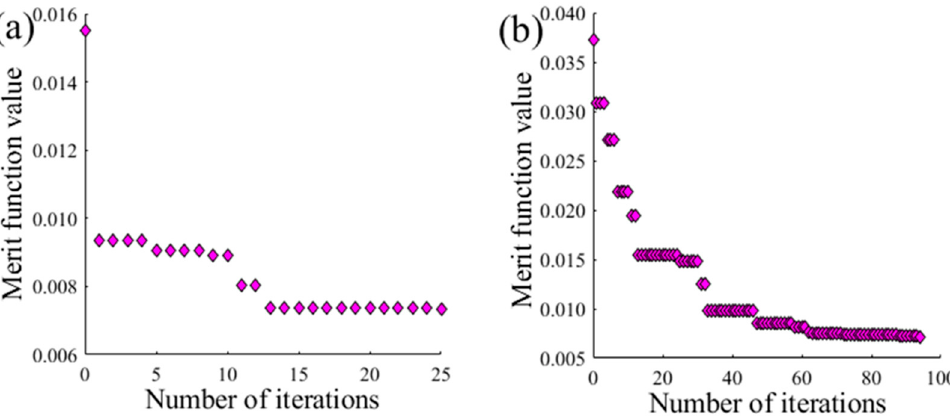
Figure 11. Progression of the experimental optimization for 1 × 9 ( a ) and 1 × 15 ( b ) beam spot arrays.